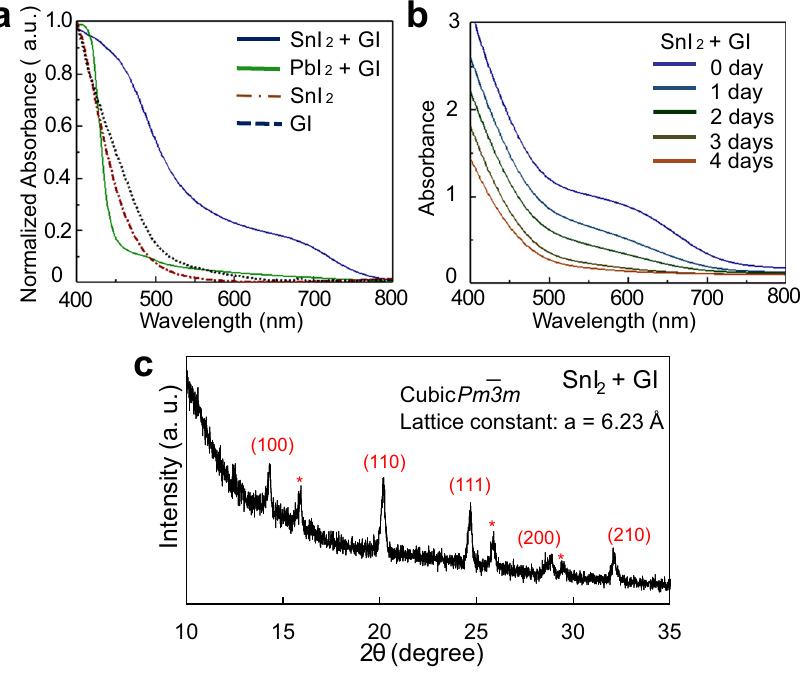
Figure 1. Characteristics of films fabricated from solution. ( a ) Absorbance spectra of PbI 2 + GI, SnI 2 + GI, SnI 2 , and GI films formed from acetone solutions. ( b ) Degradation of absorbance spectra of SnI 2 + GI film. ( c ) X-ray diffraction pattern of SnI 2 + GI